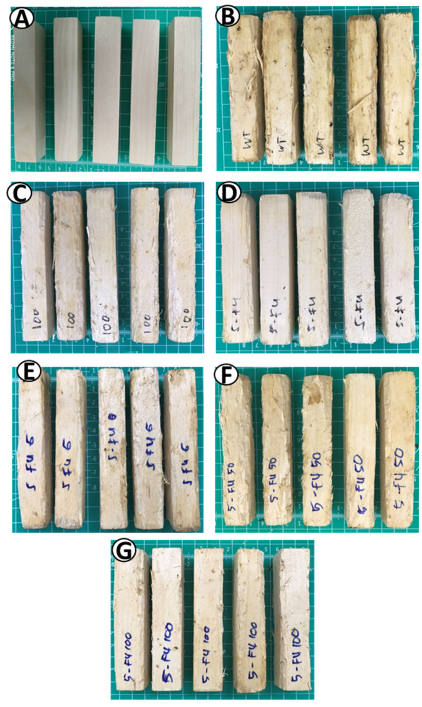
Figure 4. Images of wood blocks at the beginning and end of the experiment for the six experimental groups. ( A ) The wood blocks at the beginning of the experiment. Images of wood pieces in WT group ( B ), 100-only group ( C ), 5-FU group ( D ), 5-FU+G group ( E ), 5-FU+50 group ( F ), and 5-FU+100 group ( G